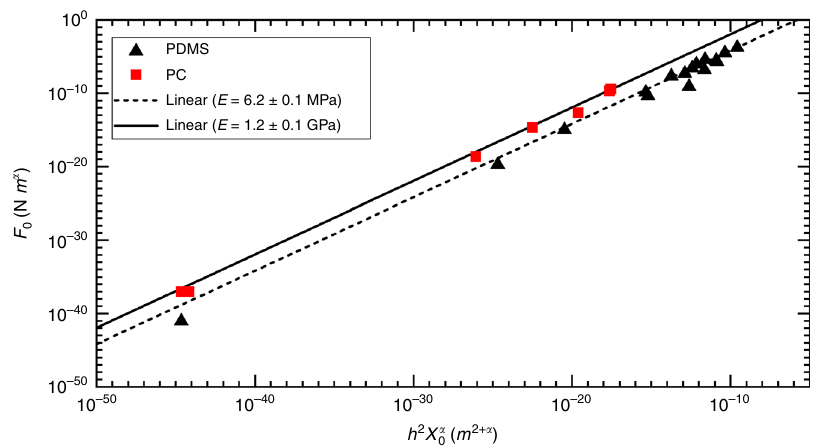
Fig. 7 Force amplitude plotted against h 2 ð X 0 Þ α . All data are well fi t by Eq. 2, yielding a second measured value of Young ’ s Modulus for each polymer. The agreement is fair, but error in modulus is underestimated by the fi t